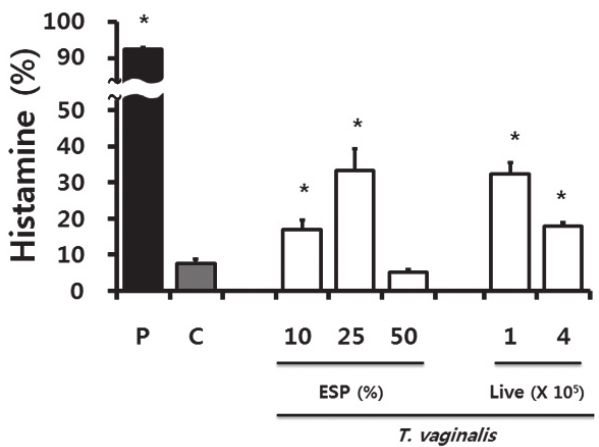
Fig. 2. – Histamine release from rat peritoneal mast cells stimulated with T. vaginalis (excretory-secretory products of T. vaginalis , and